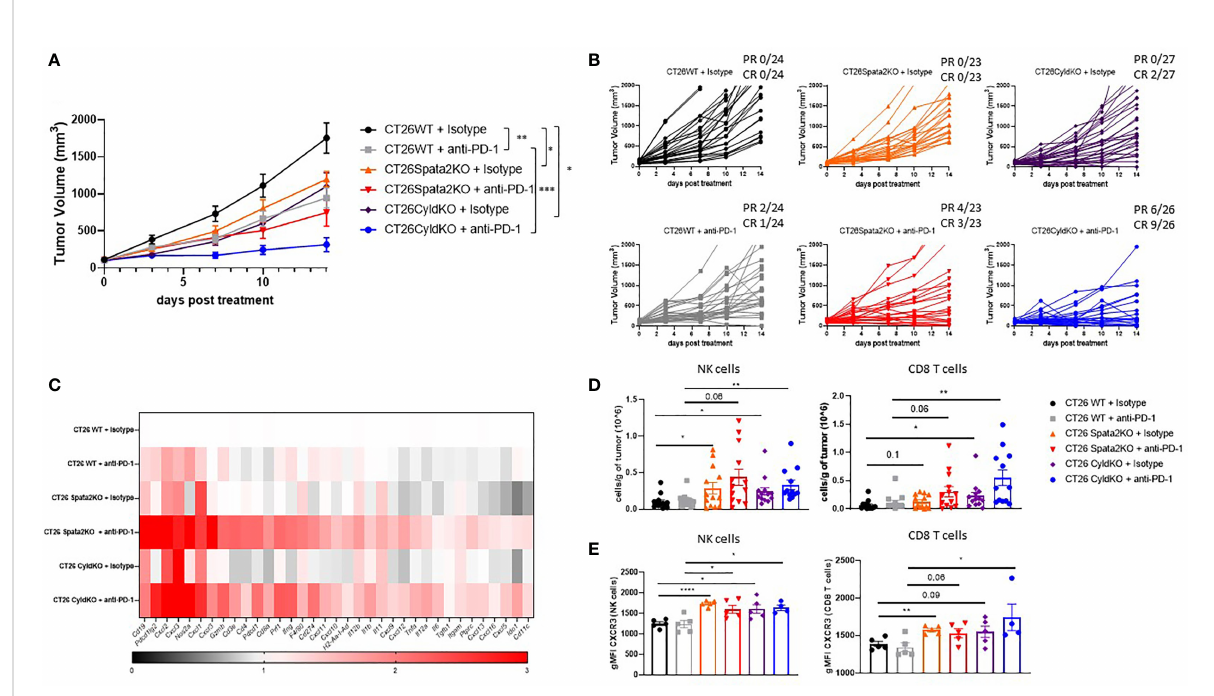
FIGURE 5 CYLD de fi ciency enhances anti-PD-1-mediated tumor regression. (A) When tumors reached an average size of 100 mm 3 , CT26 tumor-bearing mice were dosed twice weekly with the indicated antibody (at 10 mg/kg) for four doses. (B) Individual tumor growth curves. The combined results from 3 independent experiments (n=23-27 mice per group) are shown. (C) Gene expression in whole tumors from mice on day 4 after the indicated treatments. Fold-change over isotype control values represented. Results are representative of 2 independent experiments (n=8 mice per group). (D) Absolute number of CD8 + T cells (left graph) and NK cells (right graph) per gram of tumors was assessed by fl ow cytometry on day 8 post treatment. Results are representative of 3 independent experiments (n=13 mice per group). (E) CXCR3 expression level on CD8 + T cells (left graph) and NK cells (right graph) was evaluated by fl ow cytometry on day 8 post treatment. Results are representative of 1 out of